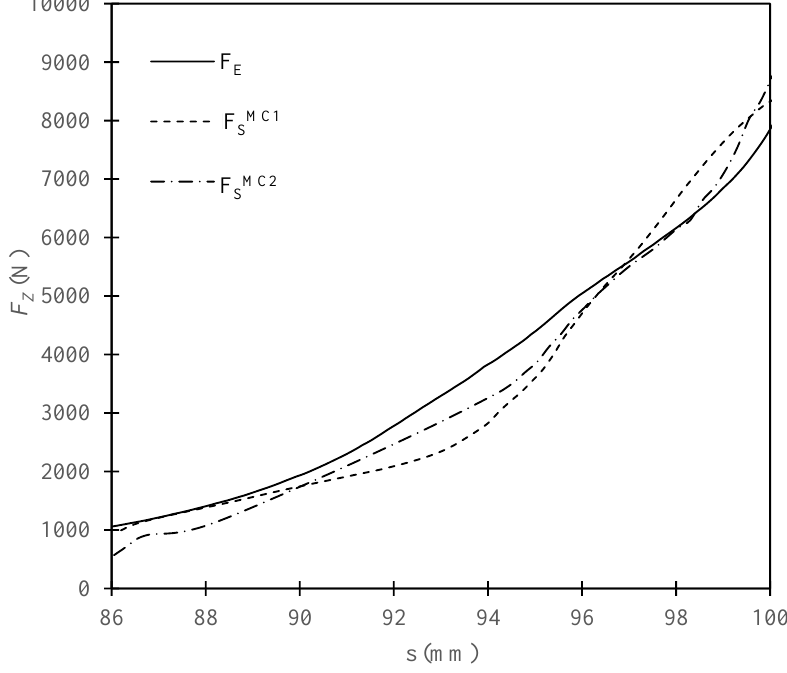
Figure 5. Change of F Z as a function of s for the observed and simulation output data